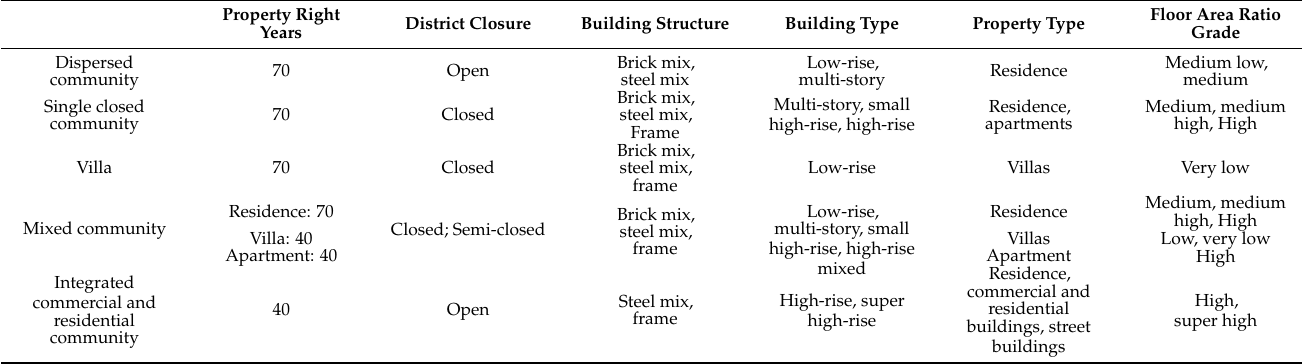
Table 2. Classification standard of the residential